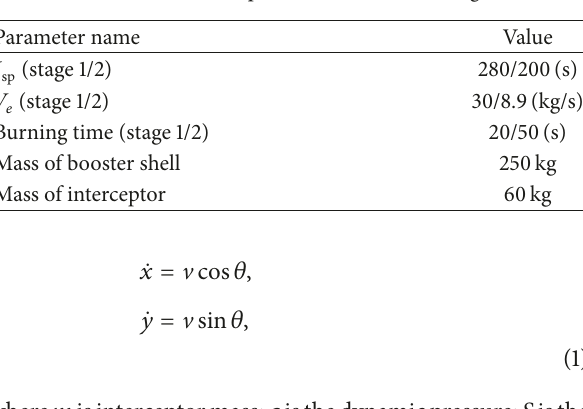
Table 1: The related parameters of booster